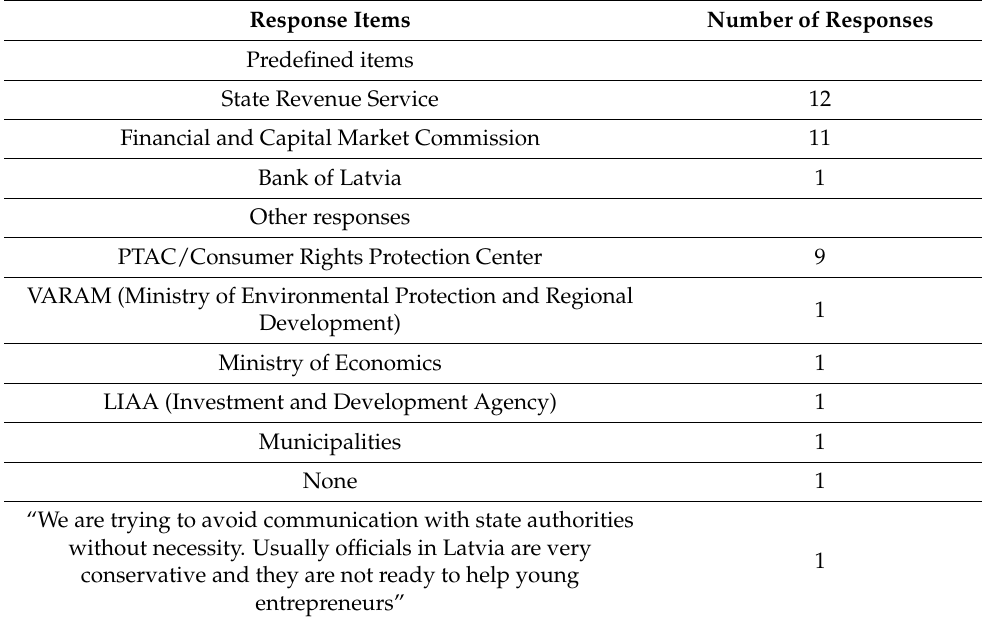
Table 4. Responses to the question of which state organizations they communicate with on a regular